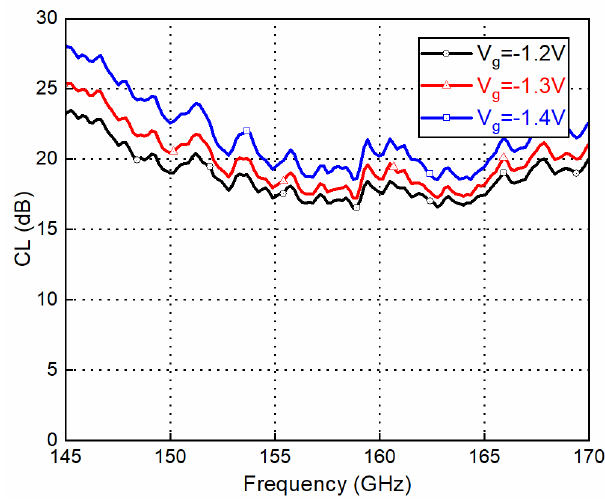
Figure 15. Conversion loss (CL) vs. frequency (IF @ 10 dBm and LO @ 13 dBm).